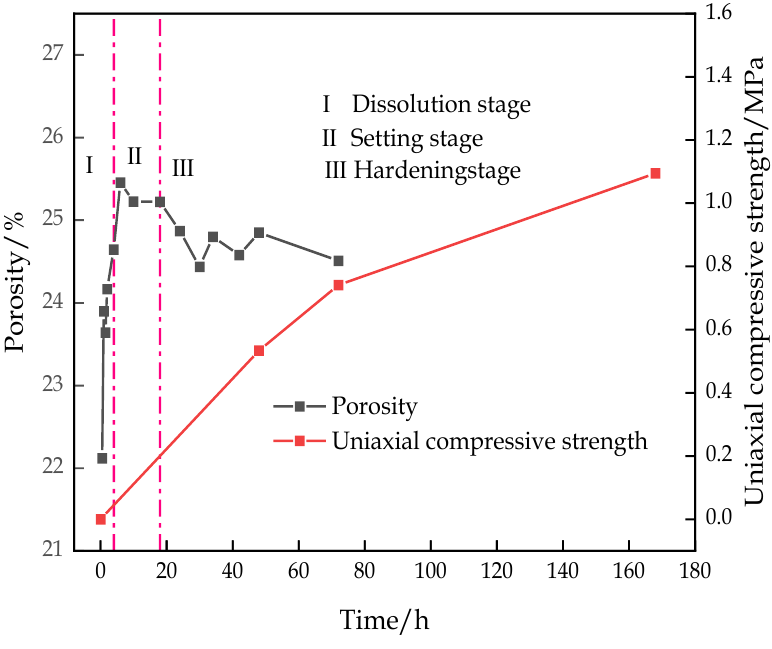
Figure 14. Curve of volume resistivity and UCS over time.